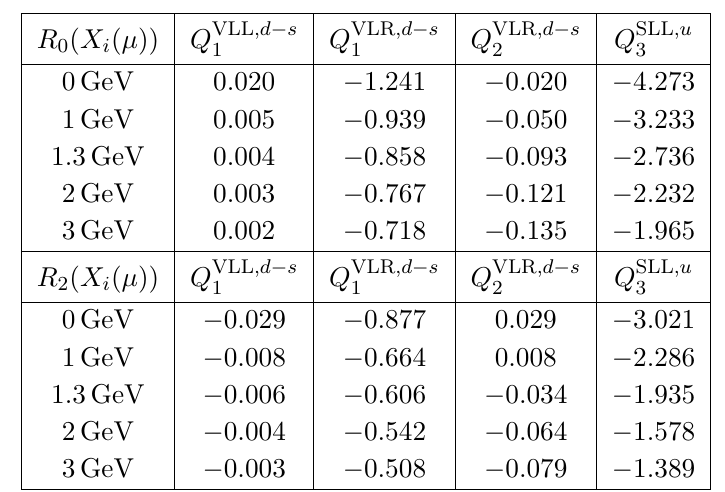
Table 7 . Ratios R I of BSM operators in the DQCD basis allowed by SU(3) SMEFT over ^ Q 8 contributing to the isospin amplitudes A 0 ; 2 for four values of (cid:22) .